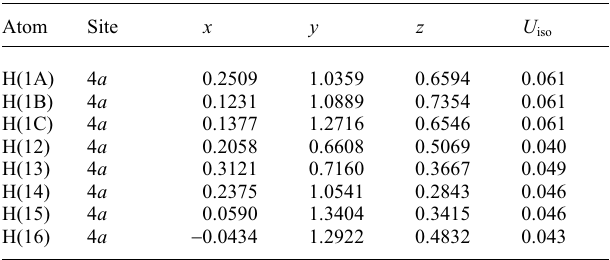
Table 2. Atomic coordinates and displacement parameters (in Å 2 )